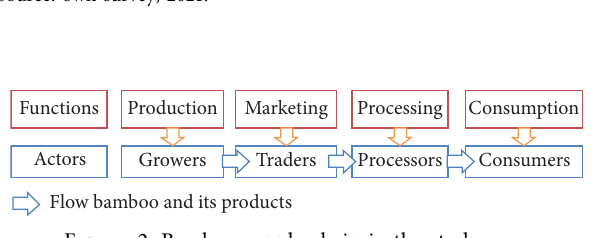
Figure 2: Bamboo supply chain in the study area.